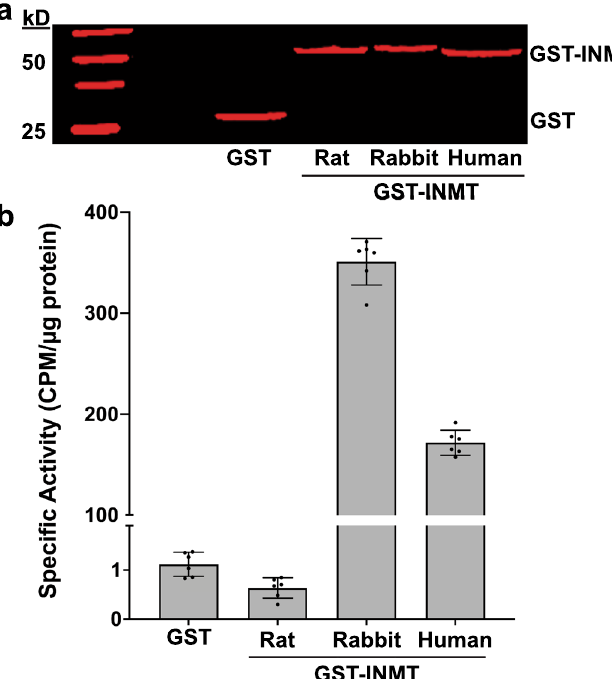
Figure 4. Rat INMT is not sufficient for tryptamine methylation. ( a ) Western blot showing expression of GST- INMT fusion proteins of rat, rabbit and human INMTs in E. coli. The control lane is showing expression of an empty vector GST, where INMT is absent. Uncropped image of the western blot is included as Supplementary Figure S3 . ( b ) Radiometric enzyme assays with extracts from E. coli expressing GST-fusion recombinant rat, rabbit, and human INMT proteins. Plots show the average of 6 individual experiments per condition with error bars indicating standard deviations. CPM = counts per minute. The assay revealed tryptamine-dependent activity of both rabbit INMT (average SA = 350.9 ± 23.08, 95% CI of mean = 326.7–375.1) and human INMT (average SA = 171.8 ± 12.38, 95% CI of mean = 158.8–184.8). Activity was significantly higher in rabbit INMT relative to human INMT ( t = 16.75, mean difference = 179.1, 95% CI = 154.3–204, p < 0.0001). The activity of rat INMT (average SA = 0.64 ± 0.21, 95% CI of mean = 0.42–0.85) was significantly lower ( t = 3.68, mean difference = − 0.48, 95% CI = − 0.77 to − 0.19, p = 0.004) than empty vector GST extracts (average SA = 1.12 ± 0.24, 95% CI of mean =